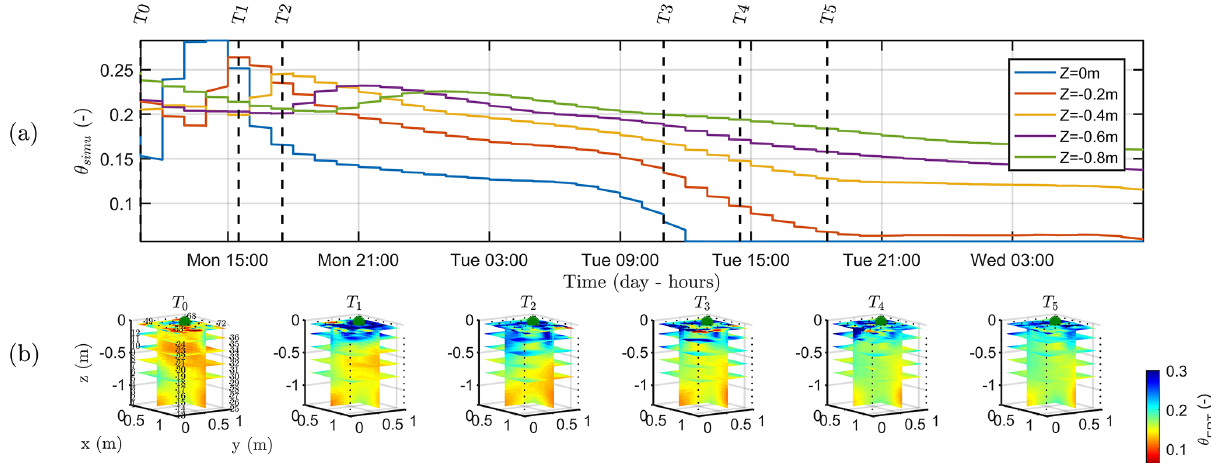
Figure 9. (a) Time variation of simulated soil water content ( θ simu ) at five depths. The vertical lines indicate the geophysical acquisition times (dashed and plain line respectively for the start and the end of the measurement; see Table 1). (b) Three-dimensional variations of the ERT-derived soil water content ( θ ERT ) for the time steps described in Table 1. Horizontal layer depths are identical to the control points of the hydrological